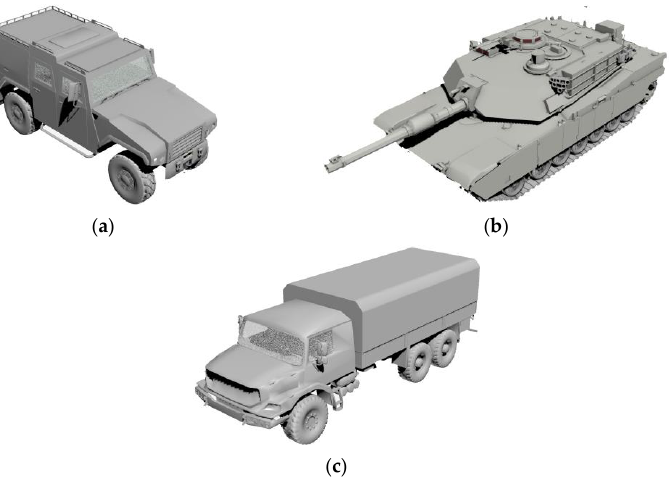
Figure 4. Geometric models: ( a ) wheeled vehicle; ( b ) tracked car; ( c ) box truck.